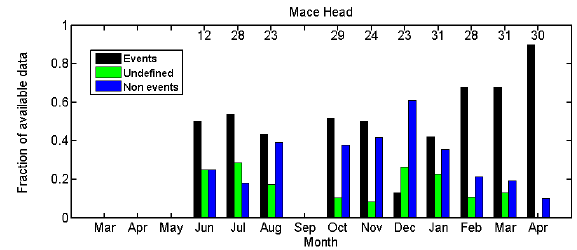
Fig. A4. The fraction of event, undefined and non-event days out of all analyzed days during each month in the year at Mace Head, Ireland, during June 2008–April 2009.